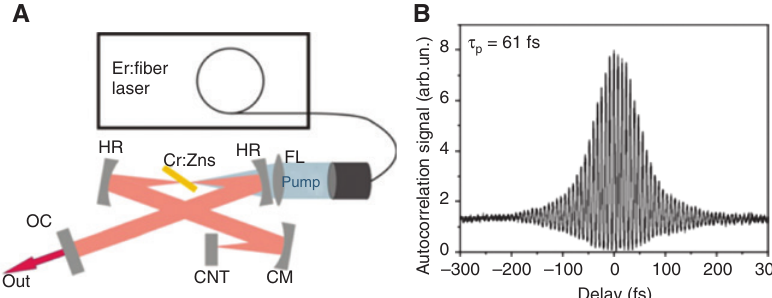
Figure 16: Schematic setup and temporal pulse profile. (A) Schematic setup for the CNT SA mode-locked Cr:ZnS laser at 2.4 μ m, C – fiber collimator, FL – focusing lens, HR – high reflector mirror, AE – Cr:ZnS active element, CM – chirped mirror, CNT – carbon-nanotubes-based saturable absorber, OC – output coupler. (B) The interferometric ACF of 61 fs pulses. Tolstik et al. [241]. © SPIE